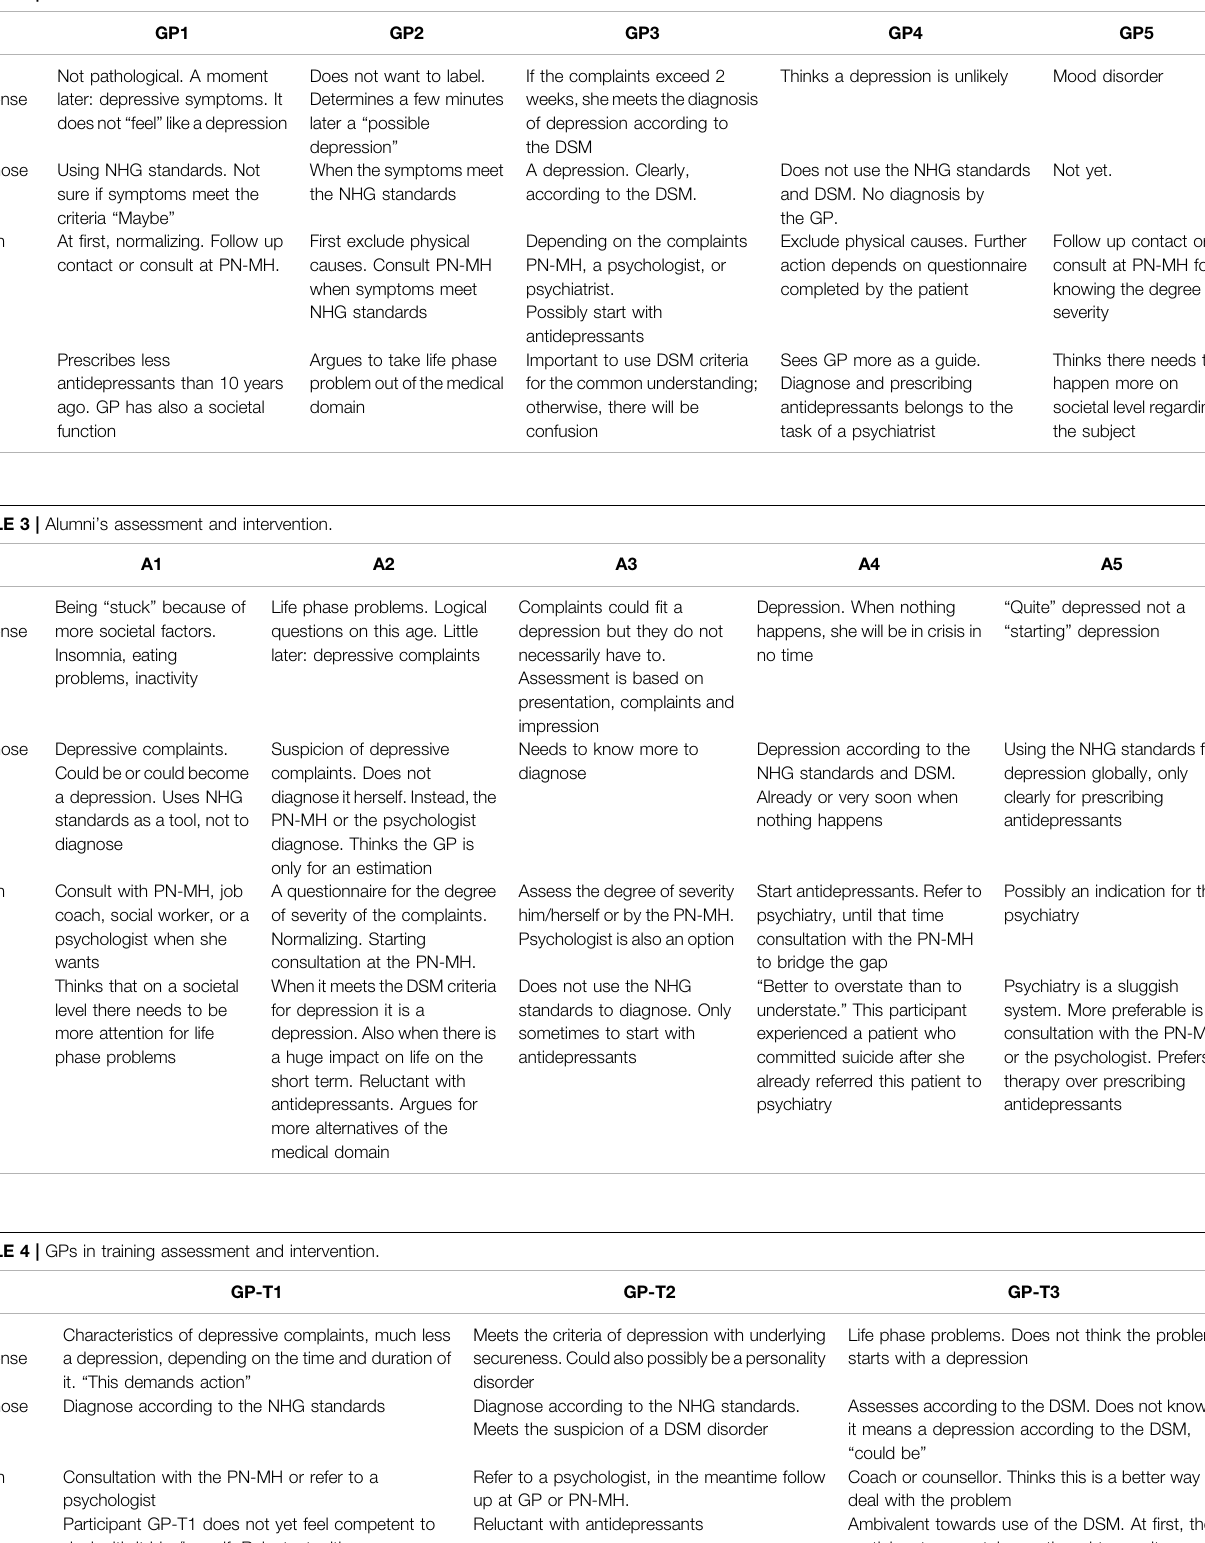
TABLE 2 | GPs assessment and intervention.